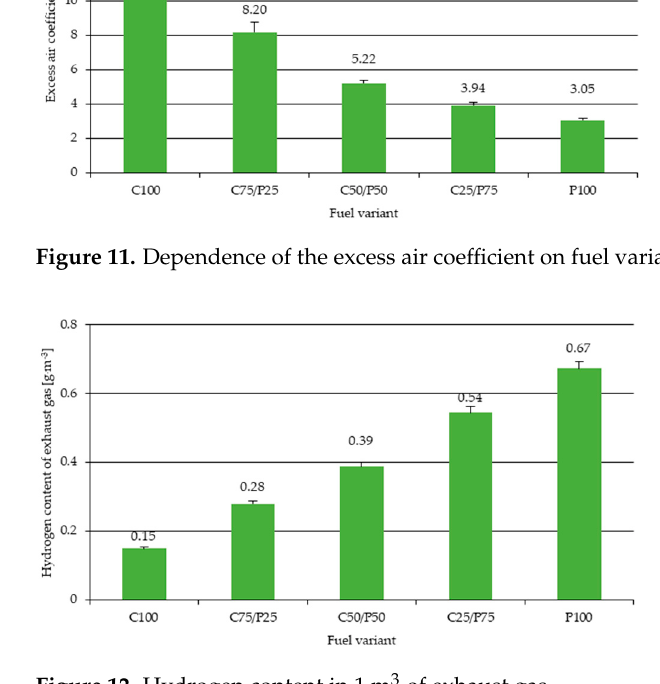
Figure 12. Hydrogen content in 1 m 3 of exhaust gas.